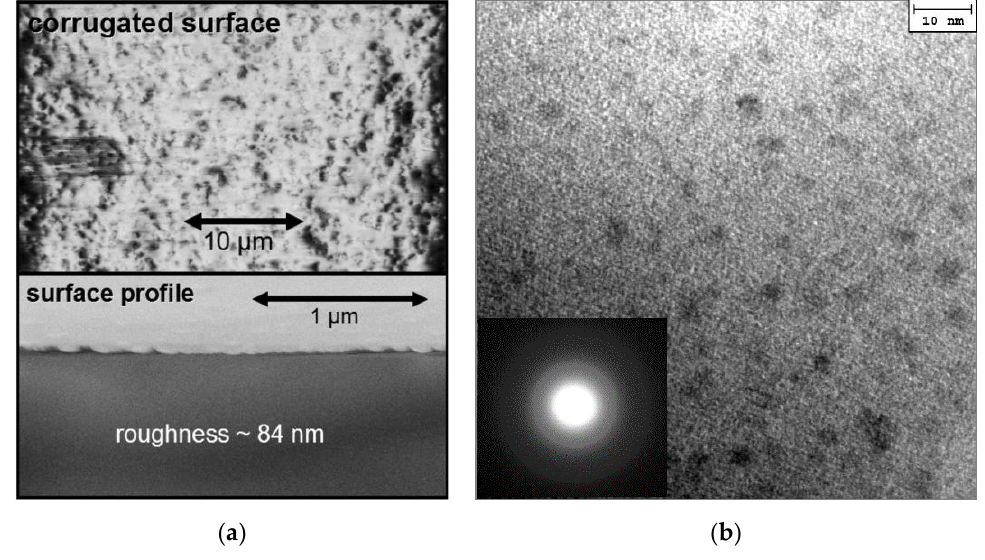
Figure 12. Scintillating fibers produced by the micro-pulling-down method: ( a ) SEM images of a LYSO fiber surface; ( b ) TEM image and corresponding selected area electron diffraction pattern (inset) of a LUAG fiber.